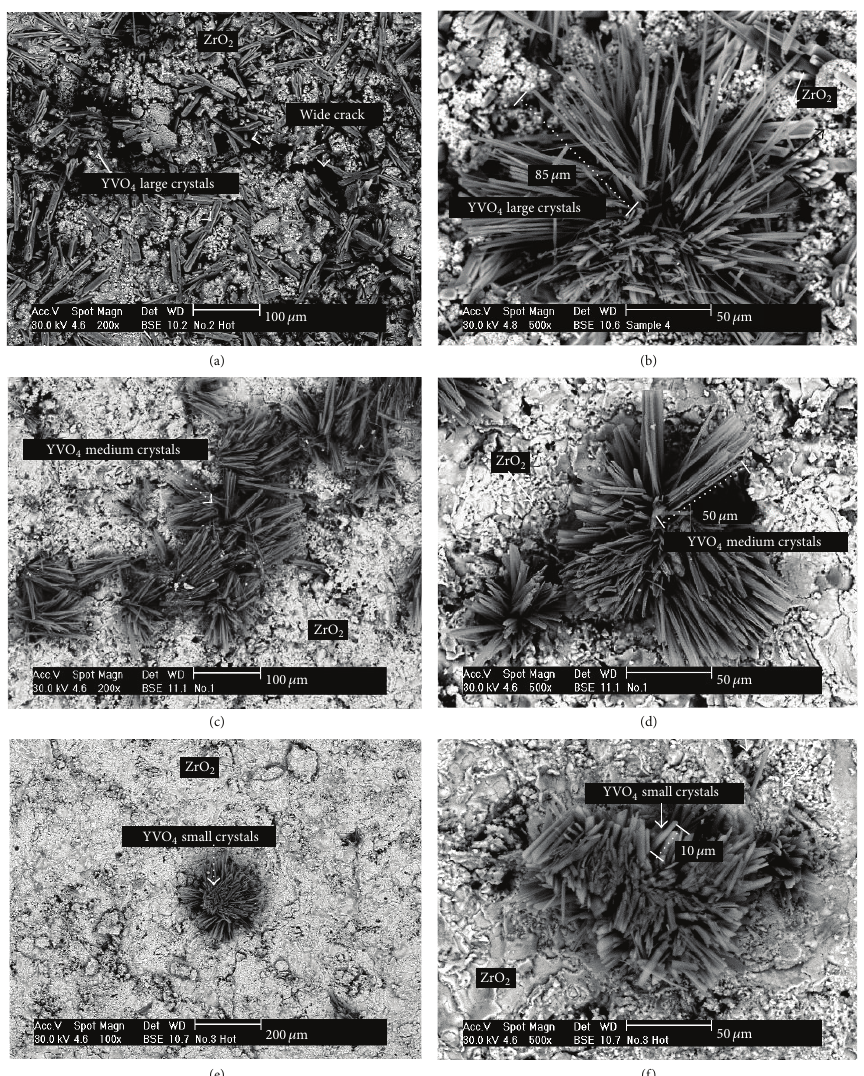
Figure 11: SEM micrographs of YVO 4 crystals on the surface of YSZ coatings: (a, b) conventional YSZ; (c, d) YSZ as inner layer of YSZ/normal Al 2 O 3 coating; and (e, f) YSZ as inner layer of YSZ/nano-Al 2 O 3 coating after hot corrosion